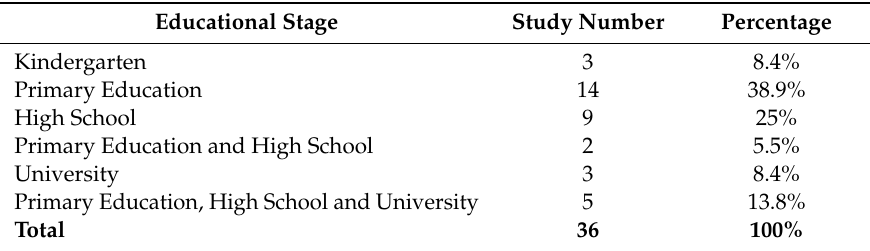
Table 2. Studies carried out at each educational